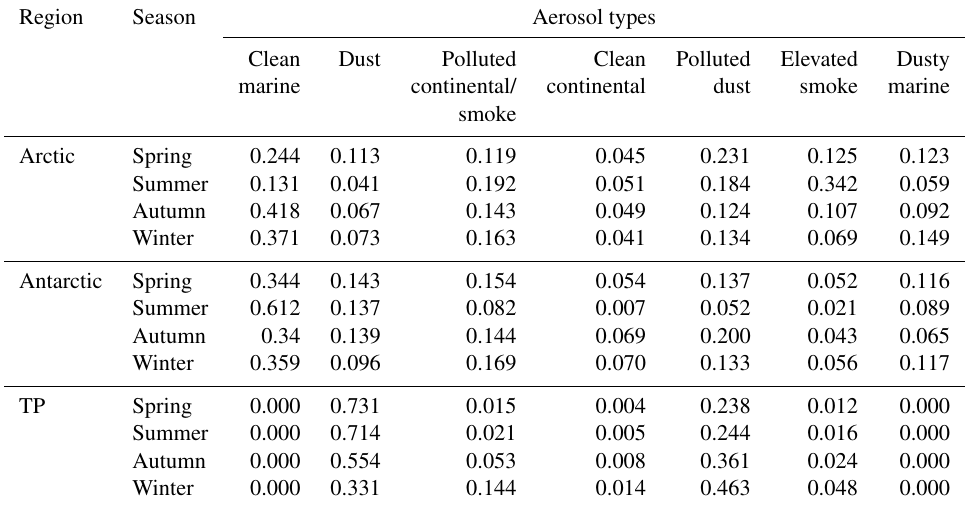
Table 1. The normalized seasonal-average OF of seven aerosol types during the study period from June 2006 to December 2019 over the Arctic, Antarctic and